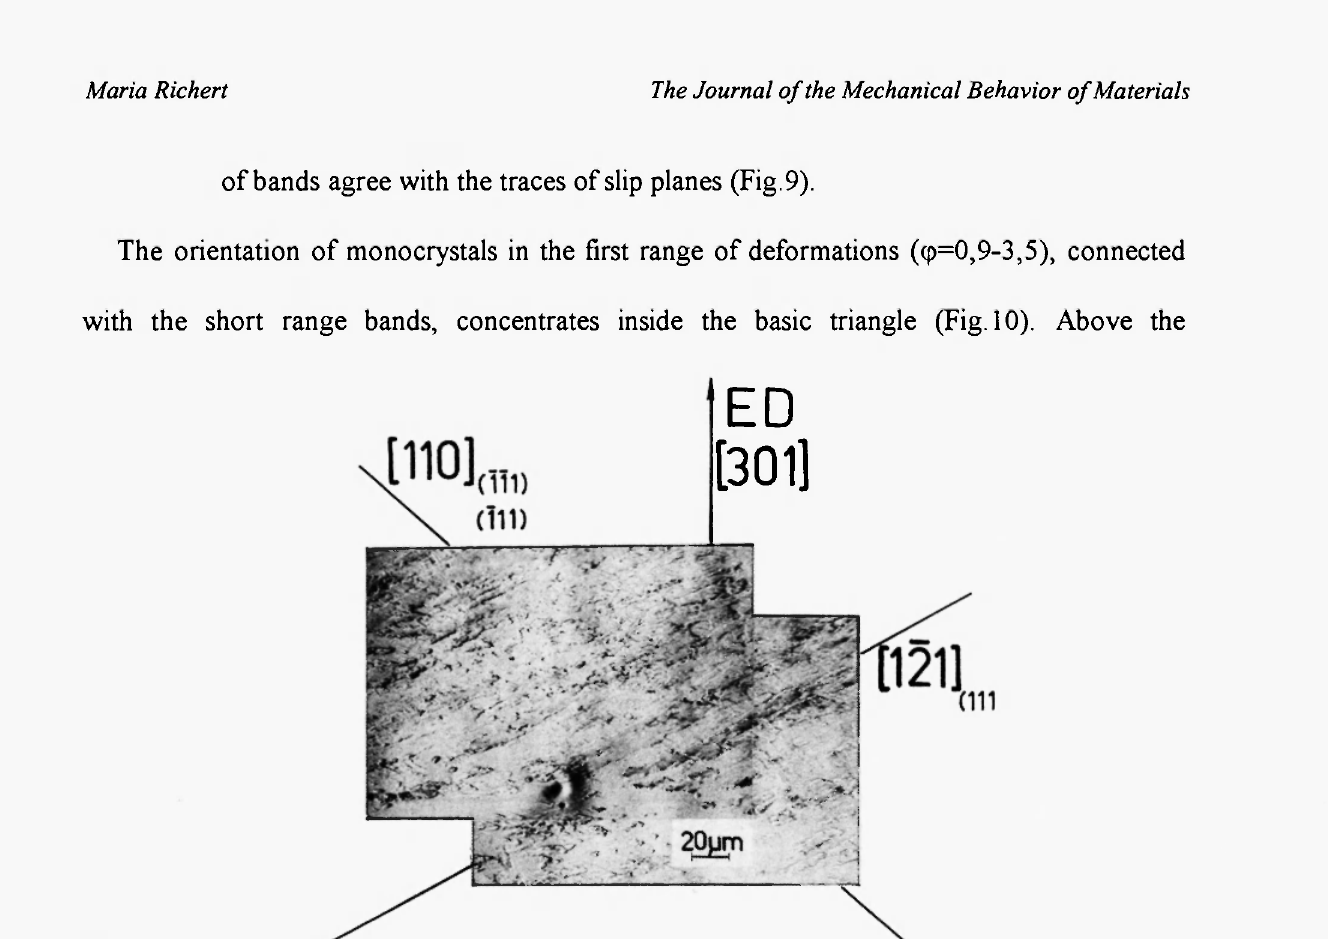
Fig.9. The square patern of crossing slip bands in the monocrystal after 30 of true strain (orientation: cross section -